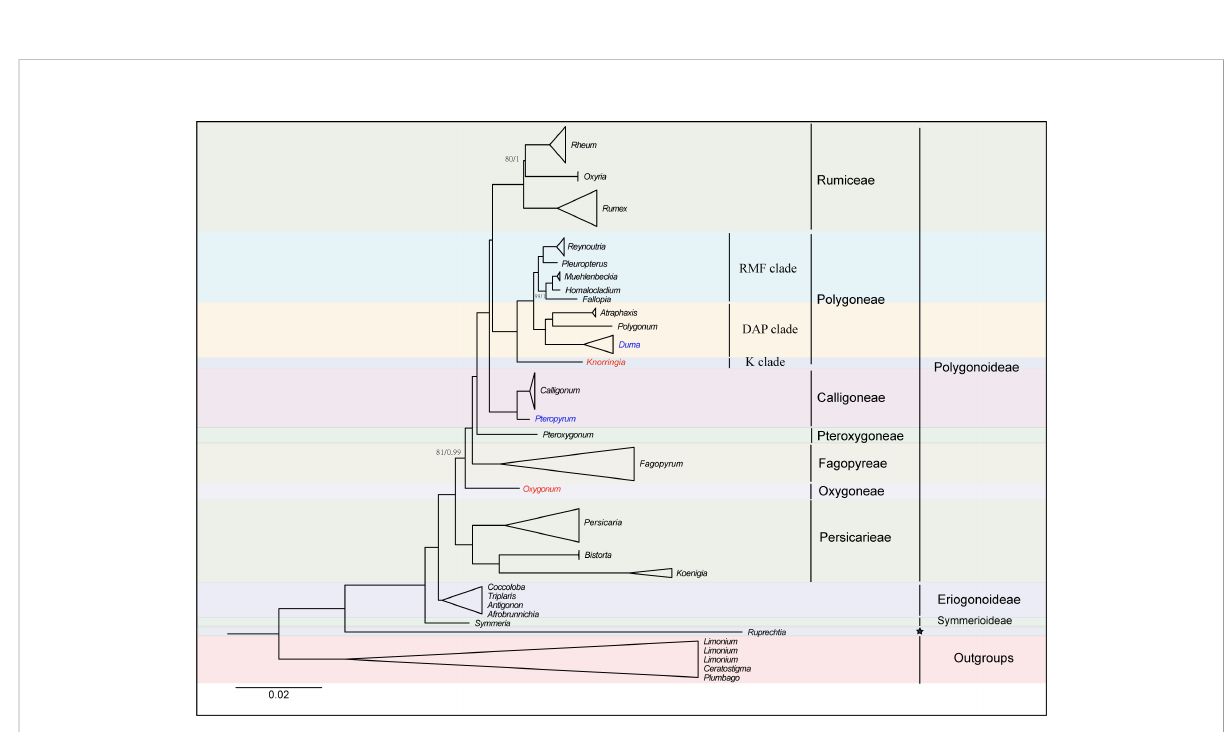
FIGURE 3 An update phylogenetic tree based on 74 shared PCGs and chloroplast fragments, with positions of species in red being generated from chloroplast fragments. Maximum likelihood bootstrap values (BS) and posterior probabilities (PP) are shown at nodes. Branches with no values listed have 100% BS and PP of 1.0 except for species with blue. Positions of species with blue were generated from previous studies (Schuster et al., 2011, 2015). Pentagram represents uncertain classi fi cation